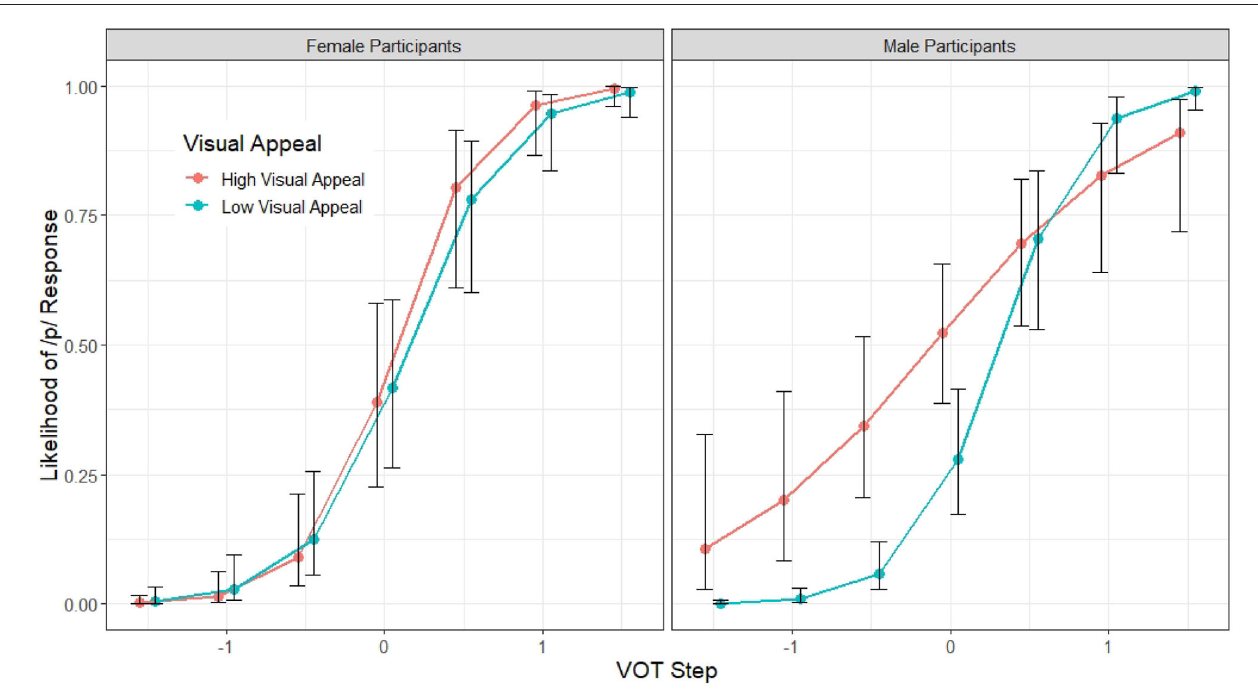
FIGURE 7 | Model 2 predictions of the probability of a /p/ response (y axis) at different steps along the VOT continuum (x axis) according to the participant’s gender as well as the talker’s visual appeal. While VISUAL APPEAL is continuous, for ease of presentation, only the patterns of talkers with high visual appeal (i.e., 2 standard deviation above the mean) vs. low visual appeal (2 standard deviation below the mean) are shown in the figure. The error bars indicate 95% confidence